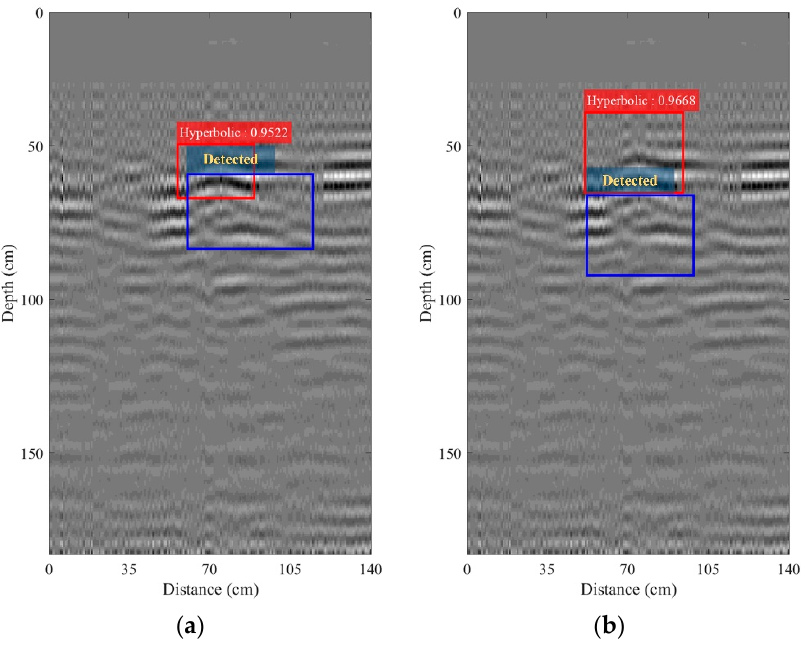
Figure 17. B-scan image collected using the maintenance train-mounted GPR system on the railway and obtained from performing bandpass filtering: ( a ) Bf = 100 MHz; ( b ) Bf = 150 MHz; ( c ) Bf = 200 MHz.